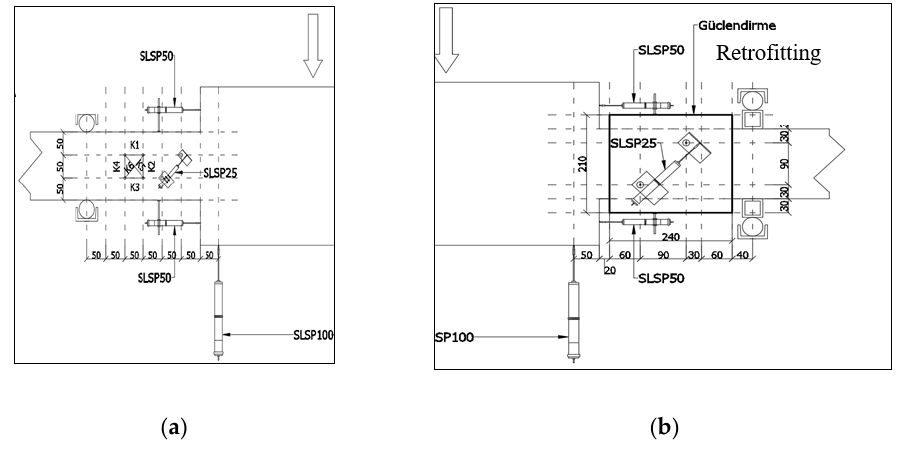
Figure 10. Measuring setup for specimens: ( a ) DS-O and DS-R; ( b ) CCRS-O and CCRS-R. The applied axial load value is 74 kN, which corresponds to 0.30f′ cjbh , where f′ cj is the concrete compression strength, and b and h are the width and height of the column, respectively. In order to keep the axial load at the same value throughout the experiment, the necessary interventions were made manually by constantly monitoring the load